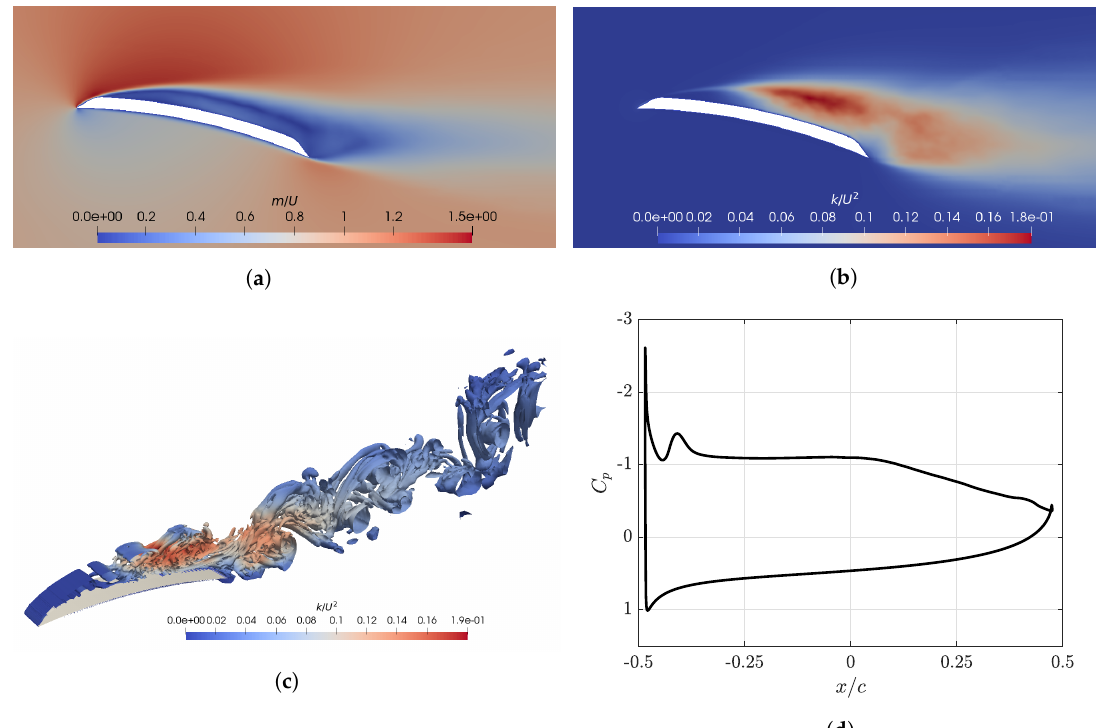
Figure 9. Flow behavior for Re = 10 4 and AoA = 12 ◦ . ( a ) Non-dimensional magnitude of mean velocity m / U ; ( b ) Non-dimensional resolved turbulence kinetic energy k / U 2 ; ( c ) Isosurface of the non-dimensional resolved second invariant of velocity gradient ˜ Q · c 2 / U 2 = 1 colored by the non-dimensional resolved turbulence kinetic energy k / U 2 ; ( d ) Pressure coefficient C p